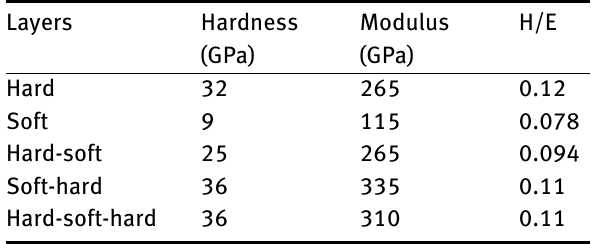
Table 1: Hardness and modulus of different mulitilayer stacked